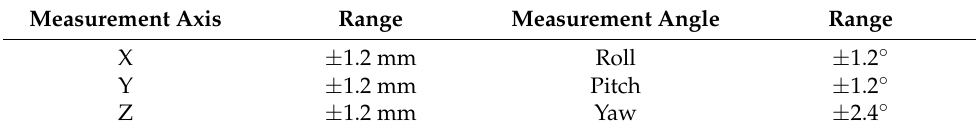
Table 2. Interface measurement